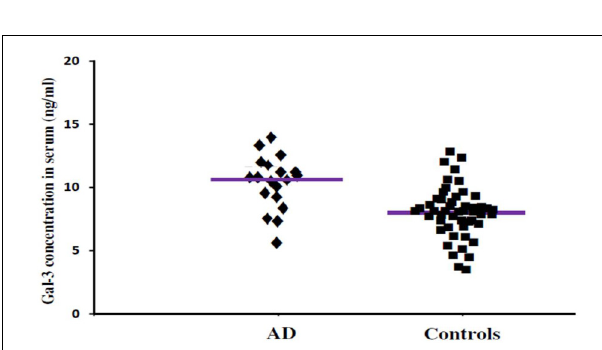
FIGURE 2 | The concentrations of Gal-3 in serum (ng/mL) of AD patients and healthy controls. AD patients showed enhanced Gal-3 concentrations in serum as compared to the healthy controls (AD vs. healthy controls [mean ± SD] 11.19 ± 3.67 vs. 8.76 ± 3.03 ng/mL; P = 0.022).